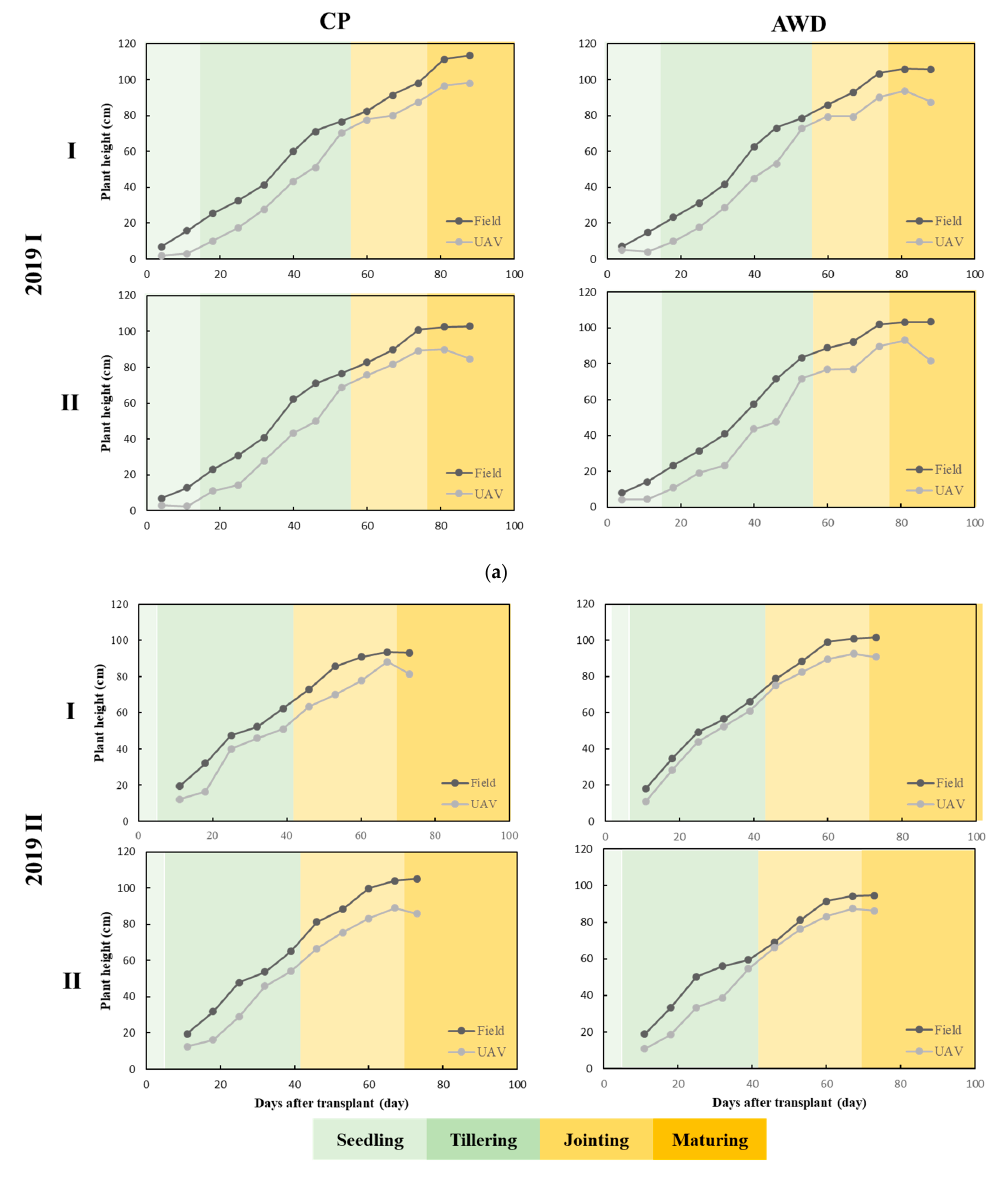
Figure 13. Comparison between UAV plant height and field plant height with developmental stages in ( a ) the first crop season; and ( b ) the second crop season.